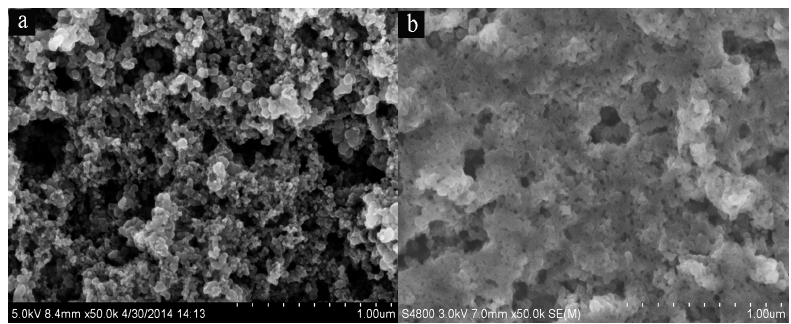
Figure 1. SEM images of carbon black ( a ) and Cu ‐ SOCBP/C ( b ).